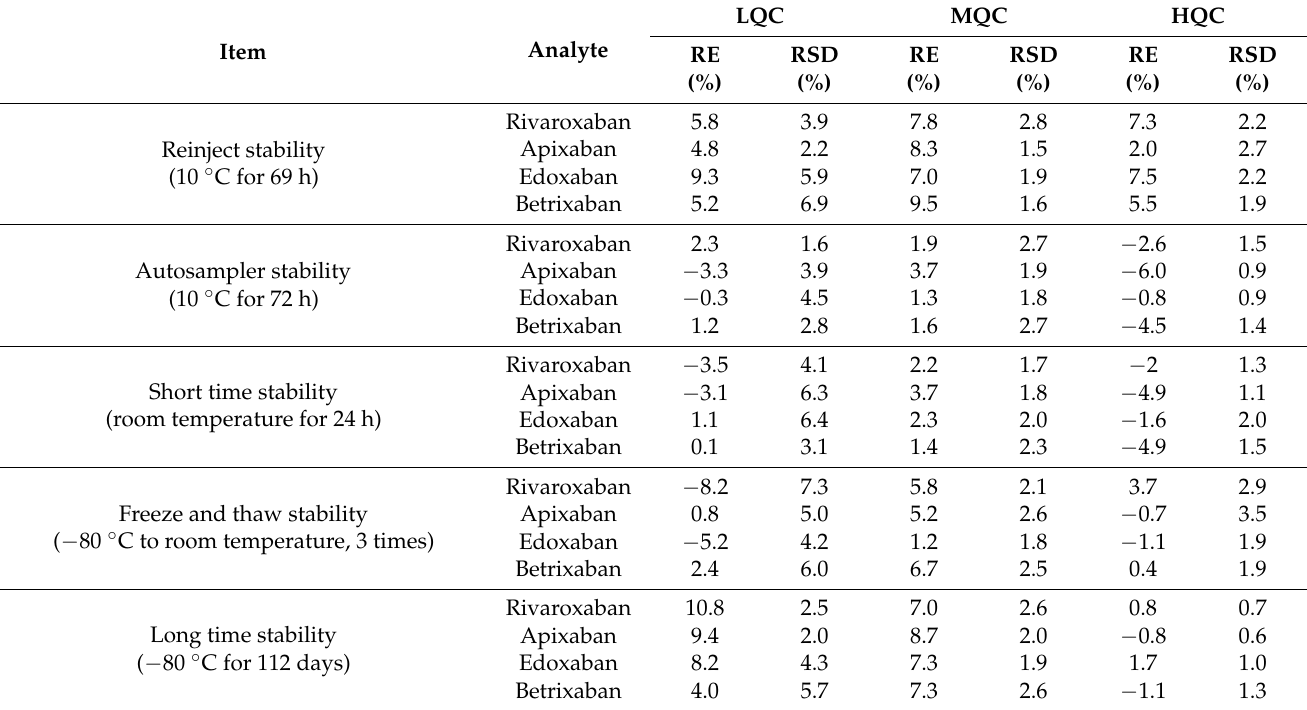
Table 6. Stability of all analytes under different conditions in